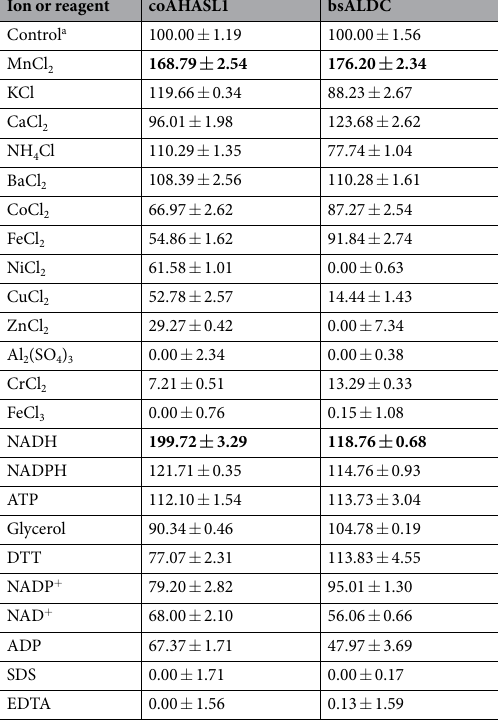
Table 2. Effects of various metal ions and organic solvents on the activities of coAHASL1 and bsALDC. a 100% was considered to be the activities of recombinant coAHASL1 and bsALDC without additives but in the presence of 1 mM MgCl 2 , respectively. ± indicates the standard deviation of three independent